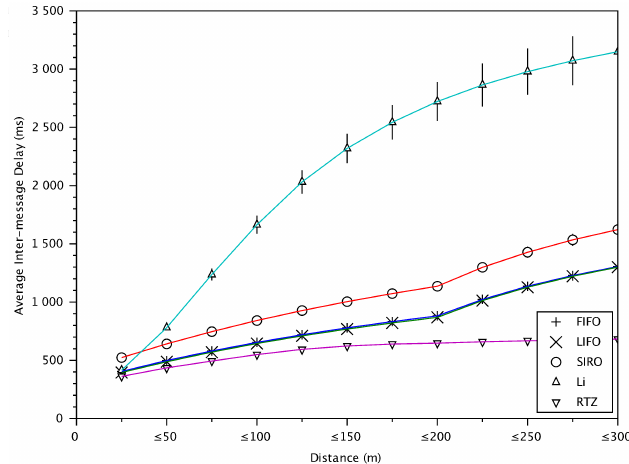
Figure 12. The inter-message delay for verified messages versus distances between transmitting and receiving vehicles.